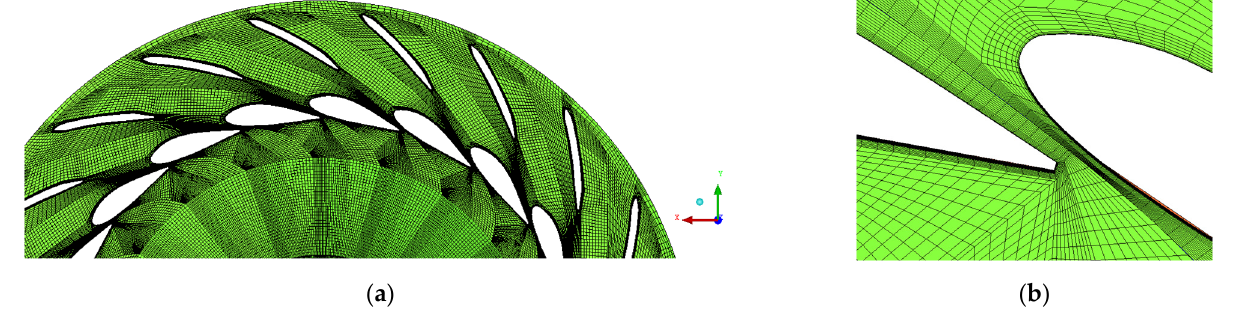
Figure 4. ( a ) Guide vane mesh. ( b ) Zoom on the inter-blade mesh.